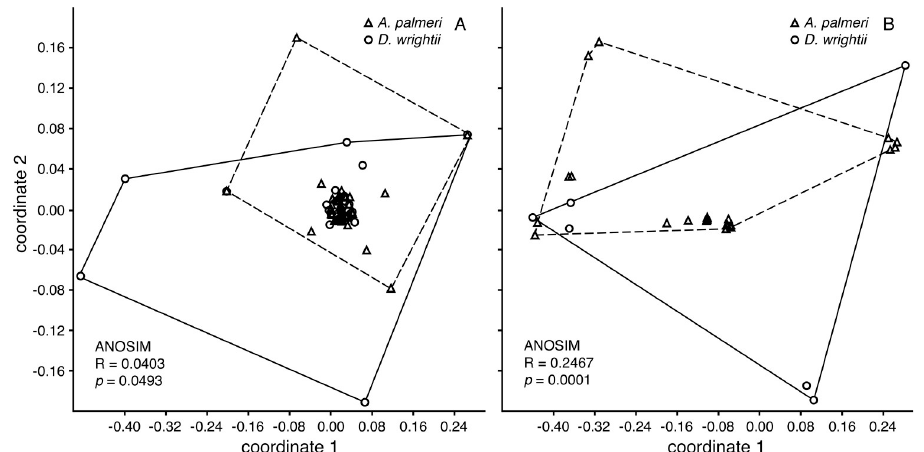
Fig 6. Community analysis of nectar microbe communities for D . wrightii and A . palmeri . Figure shows the results of non-metric multidimensional scaling based on Jaccard’s index computed with non-singleton OTU only, and ANOSIM results for (A) bacterial (N = 31 and 47 for A . palmeri and D . wrightii , respectively) and (B) for fungal communities (N = 8 and 39 for A . palmeri and D . wrightii , respectively).